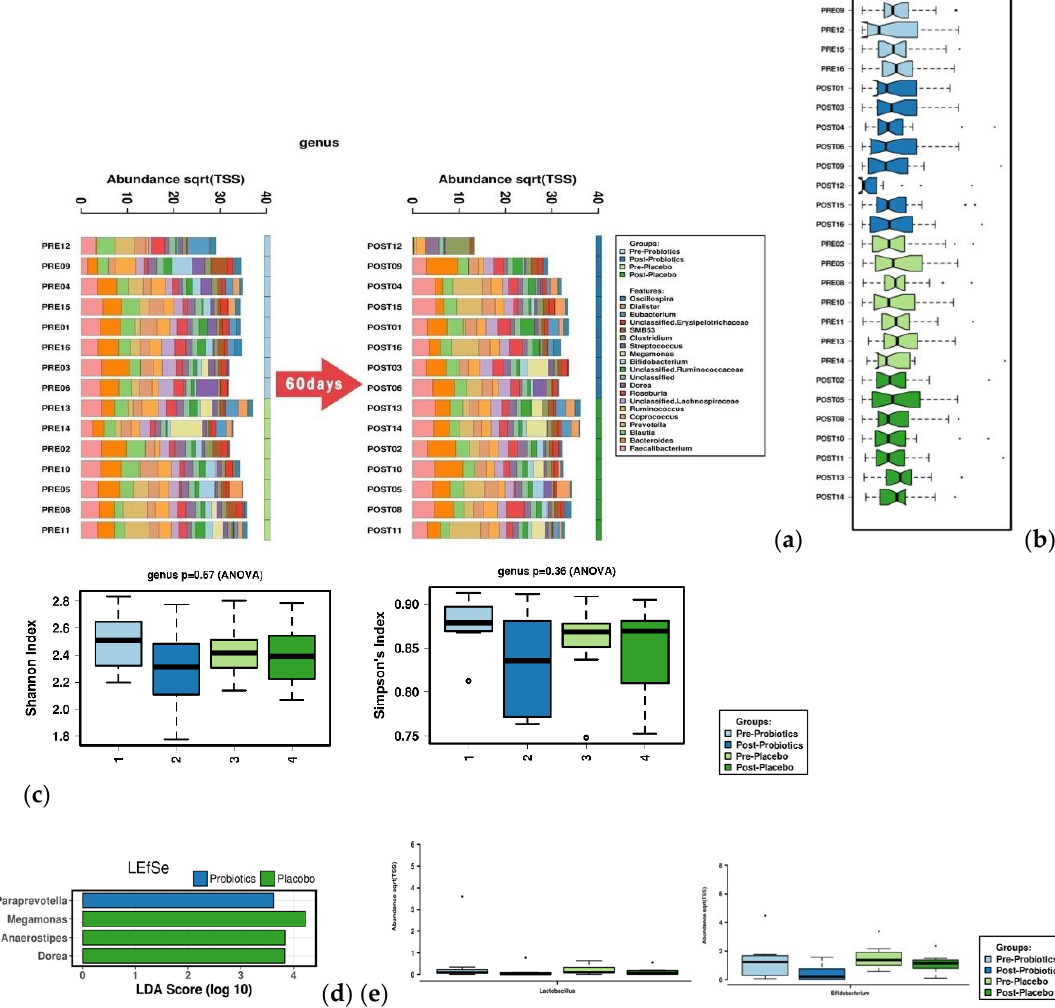
Figure 2. Microbiome analysis of groups treated with probiotics and placebo before and after supplement intake. ( a ) Changes in gut microbiome: Genus-level composition before and after 60 days of probiotic intake was analyzed by dividing the study population into probiotic intake and placebo intake groups. ( b ) The microbial composition of the probiotic and placebo groups before and after consumption was represented with BoxPlot. We stratified the sample and adjusted the opacity for clarity. ( c ) Alpha-diversity was measured with the Shannon Index and Simpson′s Index. No significant difference was observed between the probiotic and placebo groups before and after consumption. ( d ) The effect size (LEfSe) was measured via linear discriminant analysis (LDA). Based